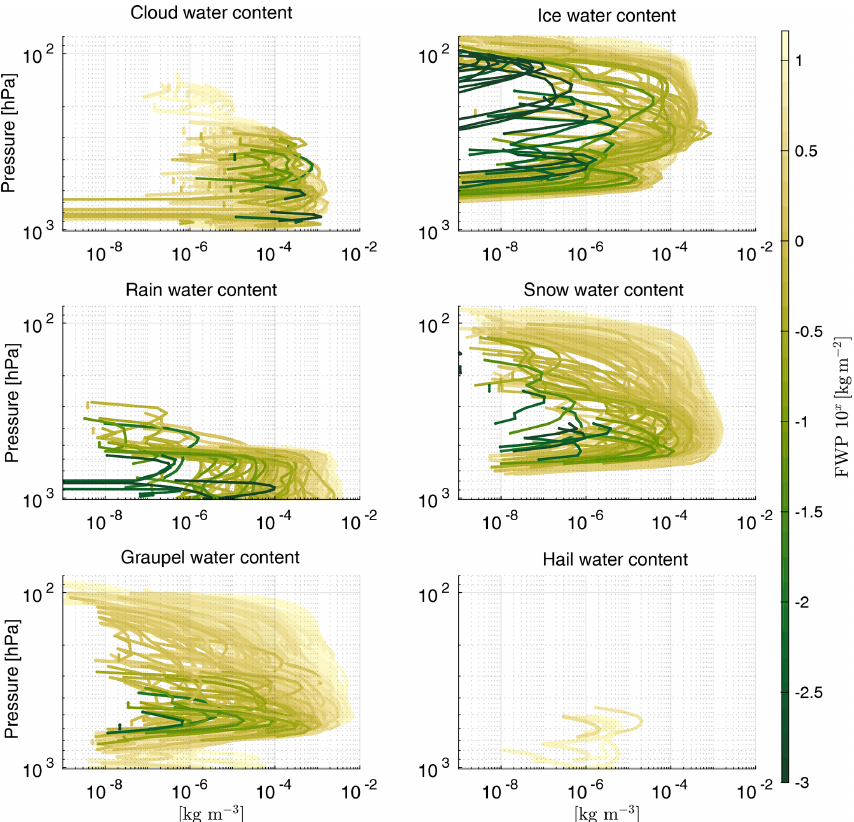
Figure 14. Hydrometeor content profiles used for the radiative transfer simulation in Fig. 12. The color indicates the frozen water path (FWP) of each atmospheric profile.